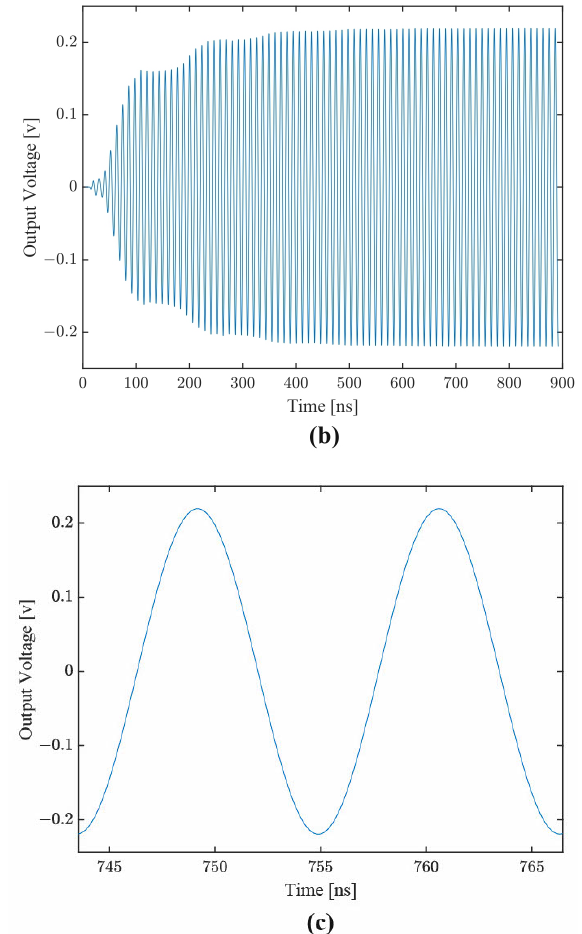
Figure 6. Time domain simulation waveforms for IDT metalization ratio of 85%: ( a ) harmonic signal with amplitude of 5 V applied to input IDT starting at time t = 0; ( b ) received signal at output IDT; ( c ) close-up of two periods of received signal from 745 to 765